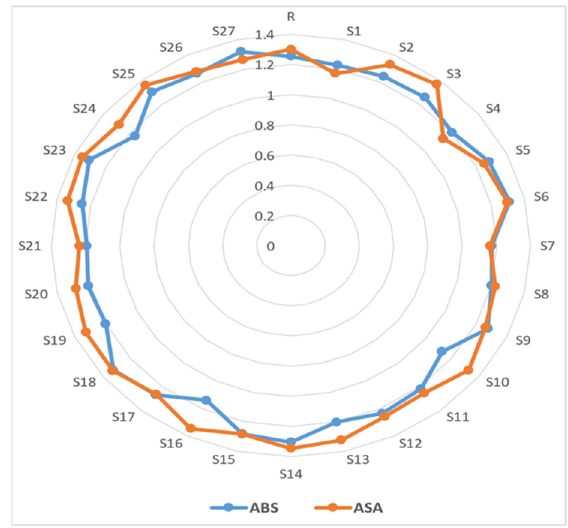
Figure 3. Two-dimensional surface profile